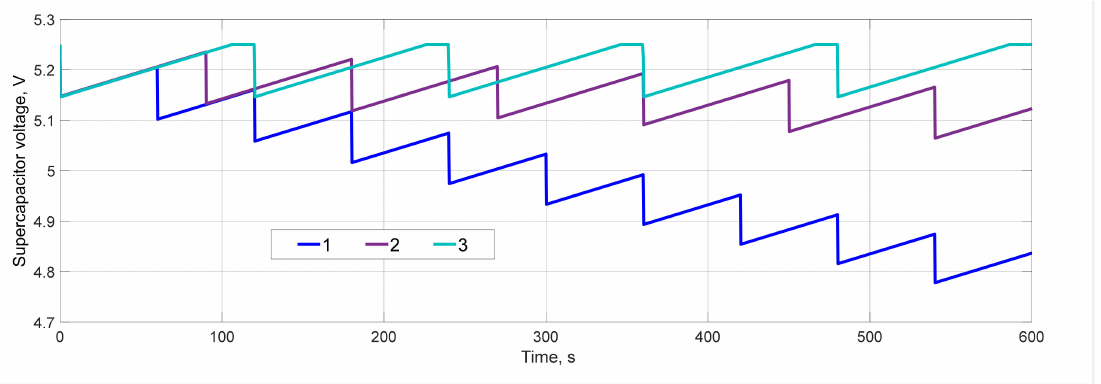
Figure 16. Virtual oscillograms of supercapacitor voltage. WSN activation periods: 60 s (1), 90 s (2), and 120 s